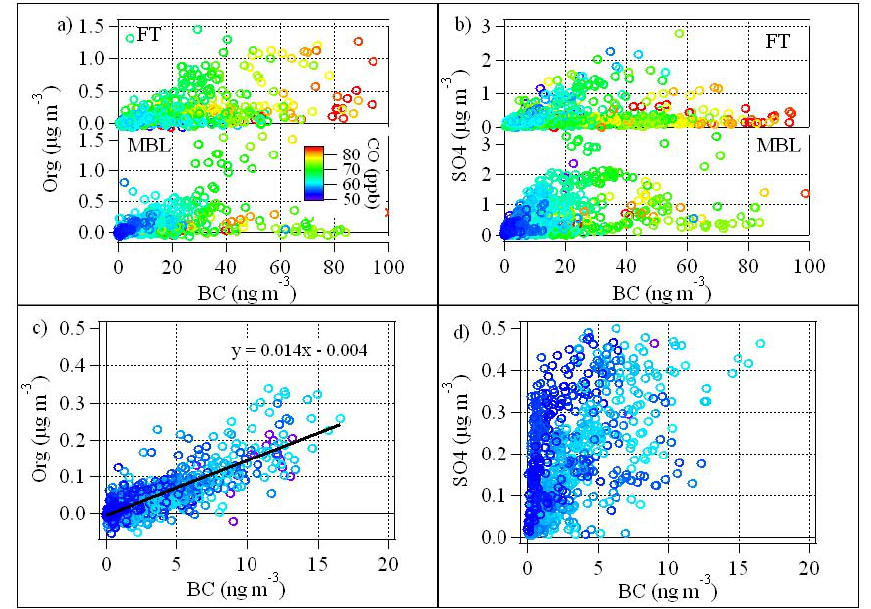
Fig. 5. (a) Org vs. BC mass, colored by CO, both above (FT) and below (MBL) the inversion, (b) SO 4 vs. BC mass, colored by CO, and (c) Org and (d) SO 4 vs. BC mass under 0.02µgm − 3 and CO less than 61ppb.